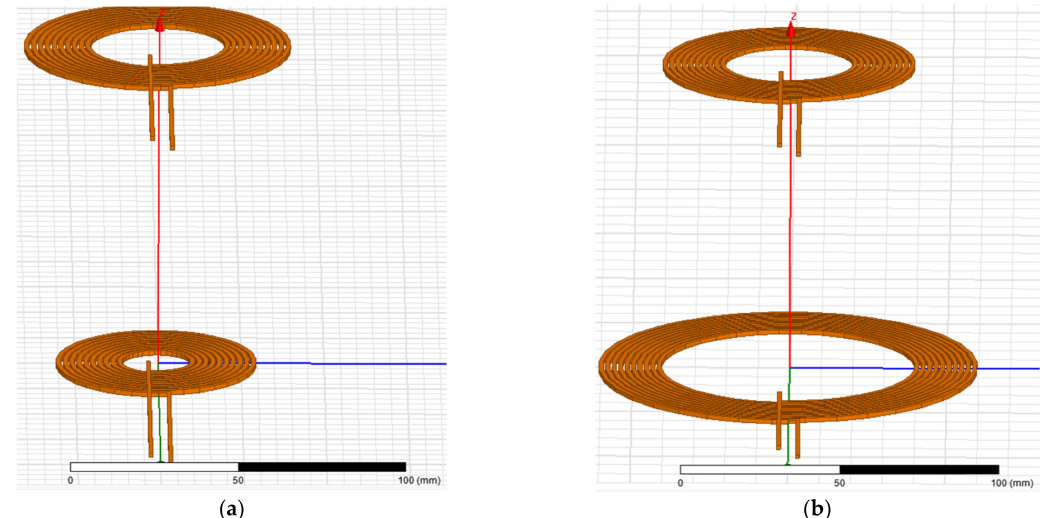
Figure 14. Coreless coil models with constant R TX : ( a ) R RX = 10 mm, ( b ) R RX = 40 mm for gap = 100 mm.